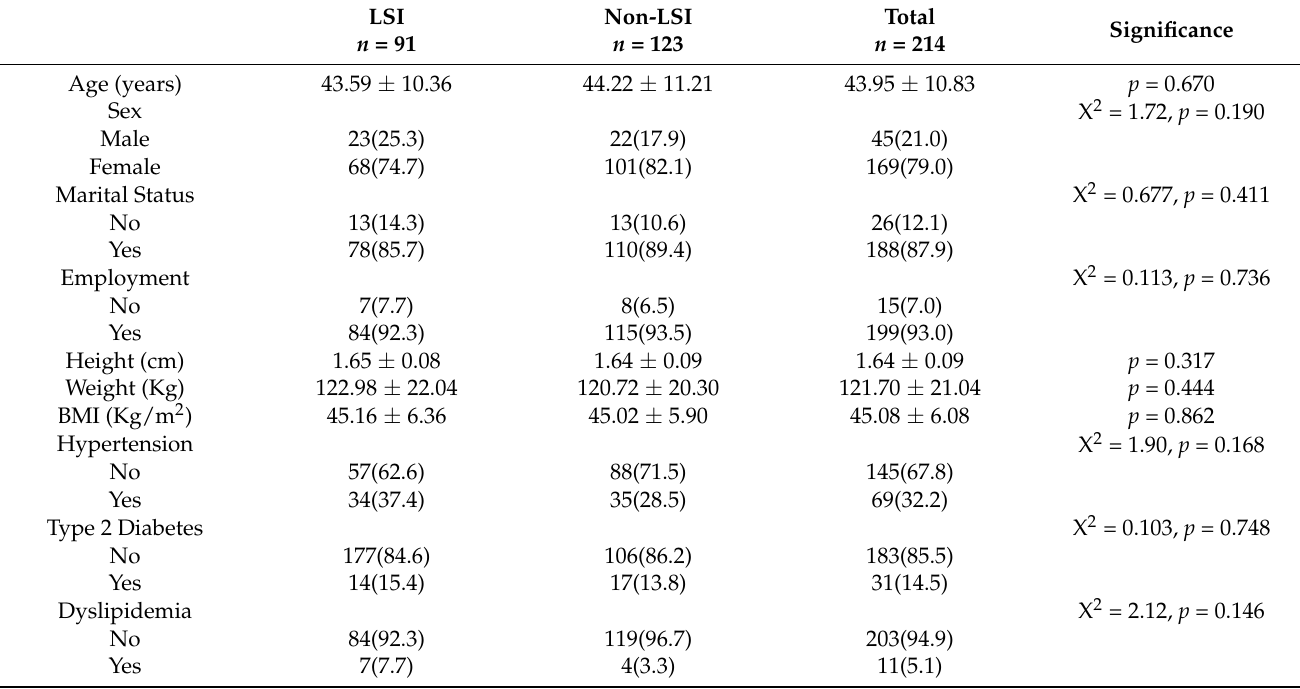
Table 1. Characteristics of the study participants before BS.